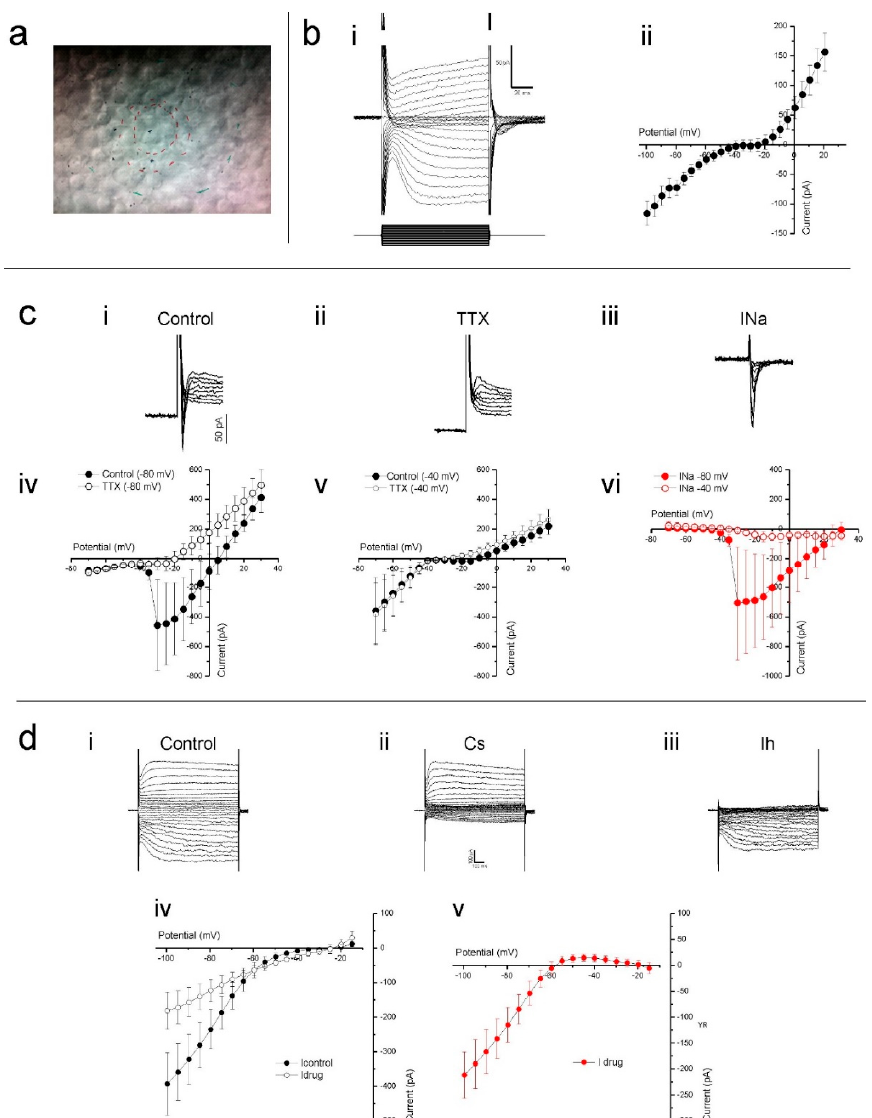
Figure 3. Cones in cultured human retinas display several prominent ionic conductances. ( a ) The cone cell bodies were typically round in shape and located on the explant surface, as most photoreceptor outer segments were either missing or severely degenerated. The red inner circle indicates the stimulus spot of 20 µ m. The other marks are other alignment references. ( b ) Slowly activating inward and outward currents are readily distinguishable when voltage clamping cones at − 40 mV and stepping them to potentials ranging from − 100 mV to + 30 mV, as demonstrated by the example given in ( b i). When plotted as an IV-relation ( b ii), a non-linearity between − 45 mV to − 15 mV is also apparent. ( c ) Clamping cones at − 80 mV then stepping them to potentials above − 40 mV often elicited a fast and transient inward current ( c i). This current did not occur in the presence TTX ( c ii, iv), a potent sodium channel blocker, nor when cones were held at − 40 mV then stepped to more depolarizing potentials ( c v). The control-TTX subtracted sodium current ( c iii) IV-relation ( c vi) further demonstrates that the current only activates if cones are initially very hyperpolarized before moving to more depolarized potentials. ( d ) Stepping cones to hyperpolarized potentials from − 40 mV induced a slowly activating inward current that CsCl blocked, as both the whole cell currents ( d i,ii) and IV-relations ( d iv) demonstrate. The control-CsCl subtracted whole cell current ( d iii) and corresponding IV-relation ( d v) bare all the characteristics associated with a hyperpolarization-activated current. Data shown as mean ± SEM in bii ( n = 12), civ-vi ( n = 5) and div, v ( n =